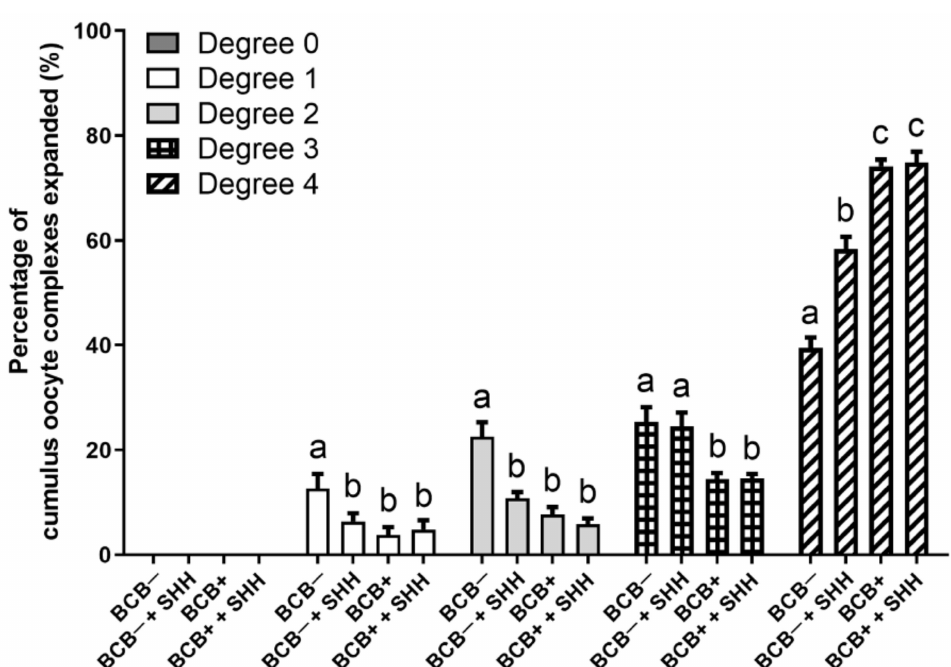
Figure 1. Effect of sonic hedgehog (SHH) protein supplementation during in vitro maturation of brilliant cresyl blue (BCB) − and BCB+ cumulus–oocyte complexes (COCs) on cumulus cell expansion. The experiment was independently replicated four times with at least 100 COCs per group. Groups indicated by different letters (a–c) represent significant differences ( p < 0.05). BCB − , BCB non-stained COCs; BCB − + SHH, BCB − COCs supplemented with 0.5 µ g/mL SHH protein; BCB+, BCB stained COCs; BCB+ + SHH, BCB+ COCs supplemented with 0.5 µ g/mL SHH